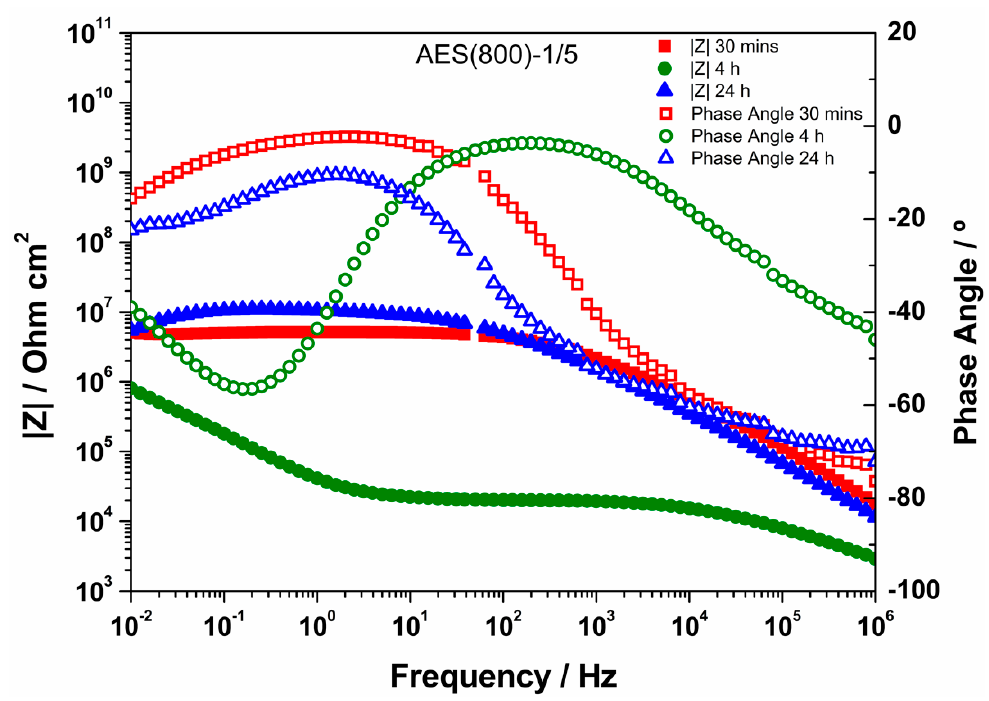
Figure 11. Bode plot for EIS analysis of AES(800)-1/5 after 30 min, 4 h and 24 h in SCPS.